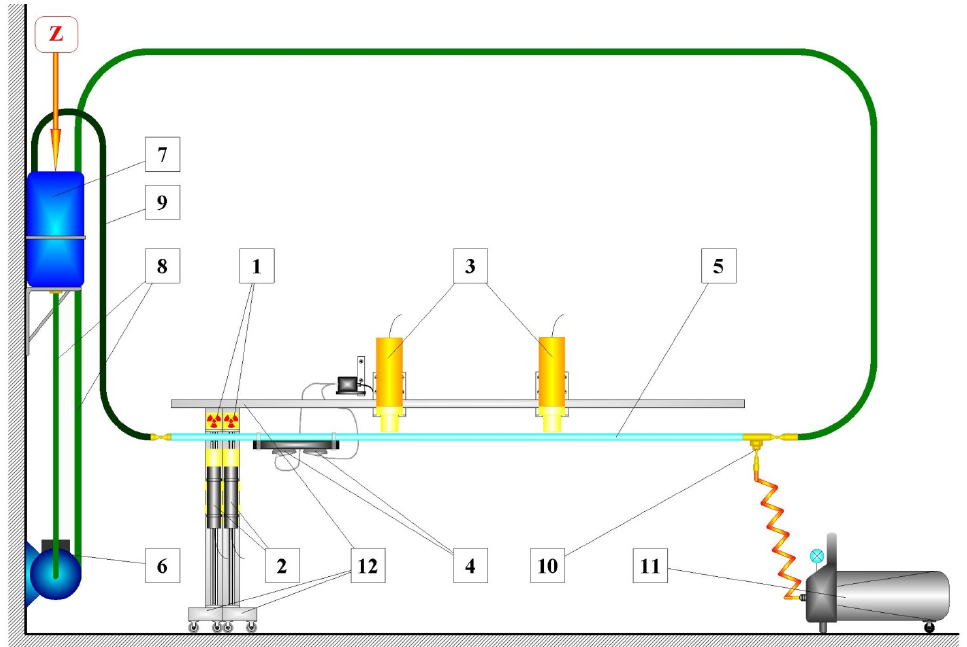
Figure 3. A diagram of the set-up to investigate water–air flow in a horizontal pipe; 1—sealed gamma-ray source; 2—detector for absorption measurement; 3—probe for tracer measurement 4—ultrasonic flow meter; 5—measurement section (Plexiglas pipe); 6—pump; 7—air-removal container; 8—feed hose (supply pipe); 9—return line (return hose); 10—air nozzle; 11—compressor; 12—shifting system of absorption set; Z—radiotracer injection.